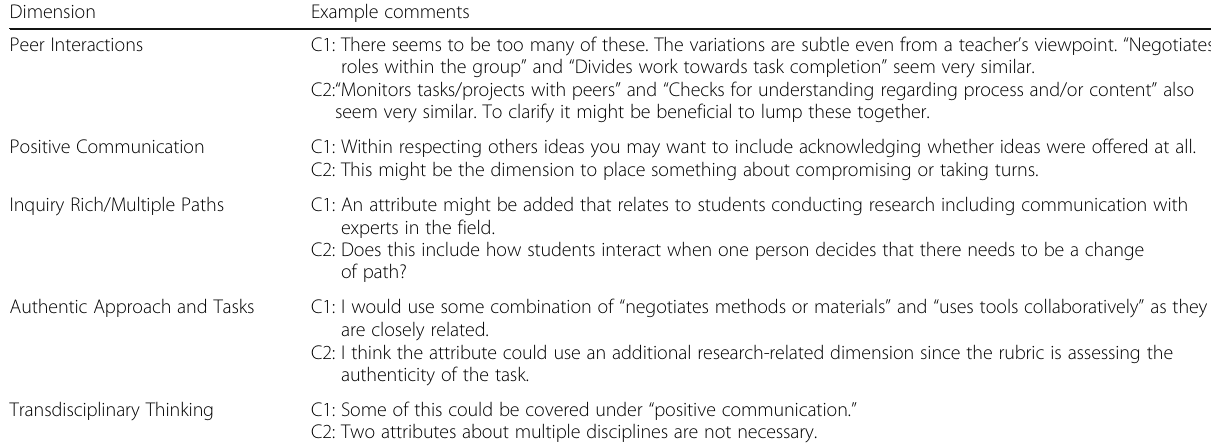
Table 3 Example comments from panelists by dimension Dimension Example comments Peer